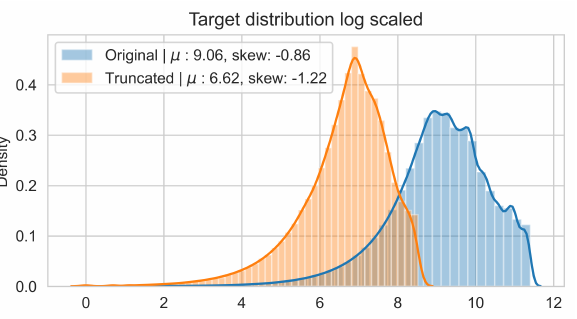
Figure 11. Distribution of RUL values before and after truncation for the SMLL bearings.